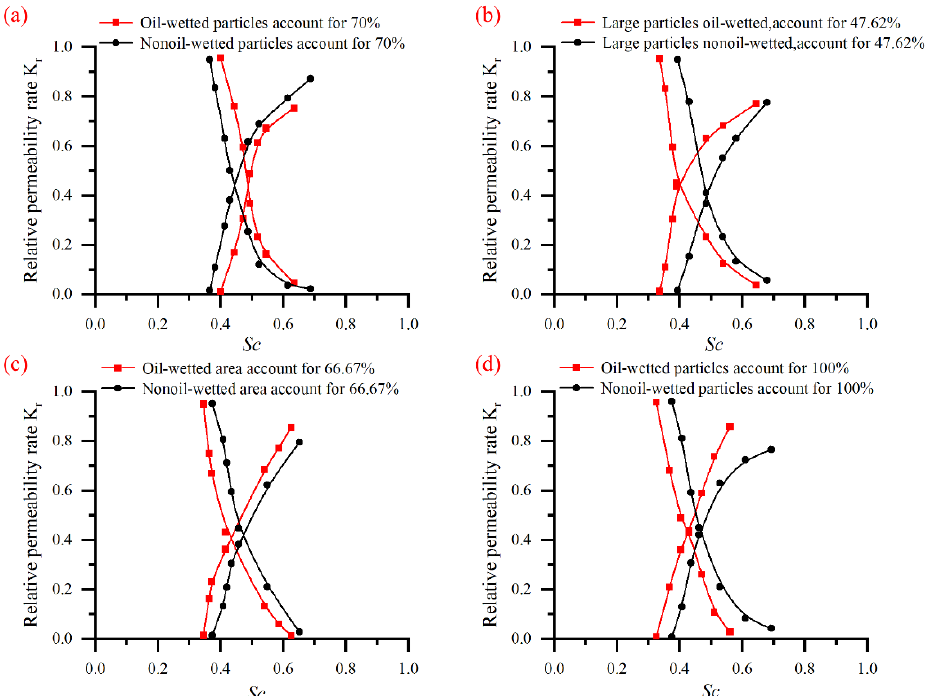
Figure 23. Oil/CO 2 relative permeability curve during CO 2 flooding under mixed wettability. ( a ) Random distribution of mixed wettability; ( b ) Large particles, oil ‐ wetted/nonoil ‐ wetted; ( c ) Oil ‐ wetted/nonoil ‐ wetted area account for 66.67%; ( d ) All particles are oil ‐ wetted/nonoil ‐ wetted.